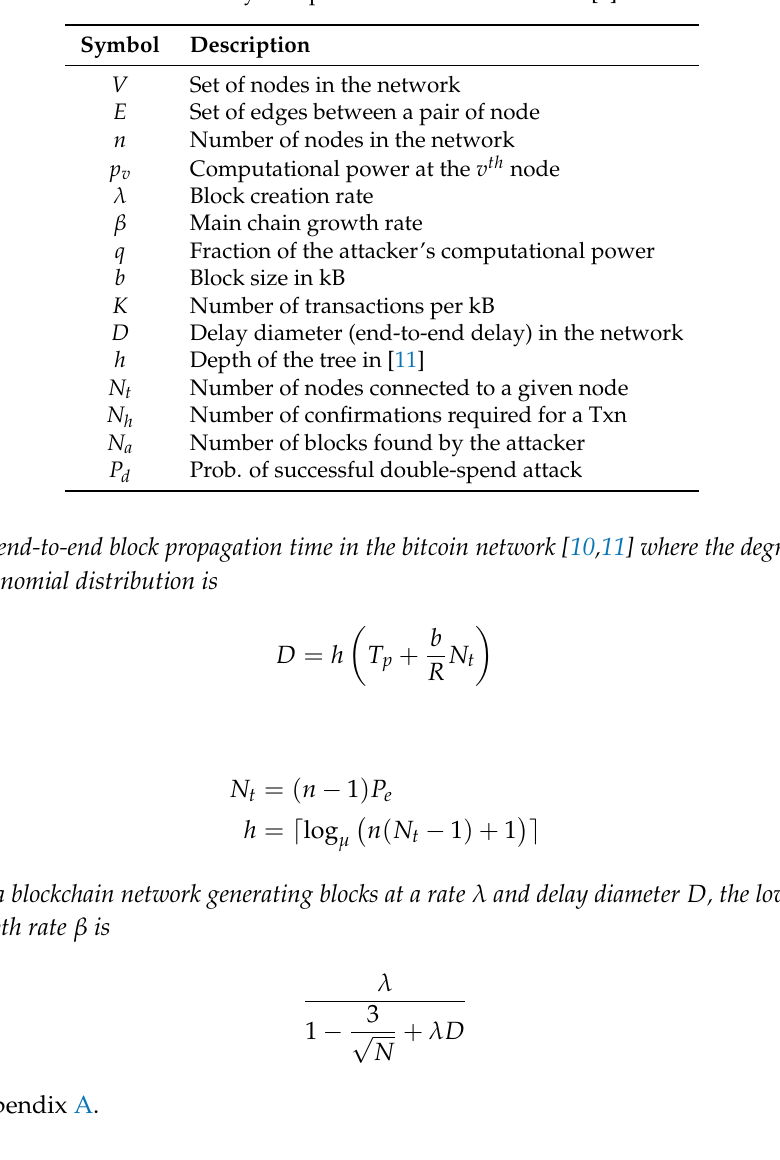
Table 1. System parameters for the model in